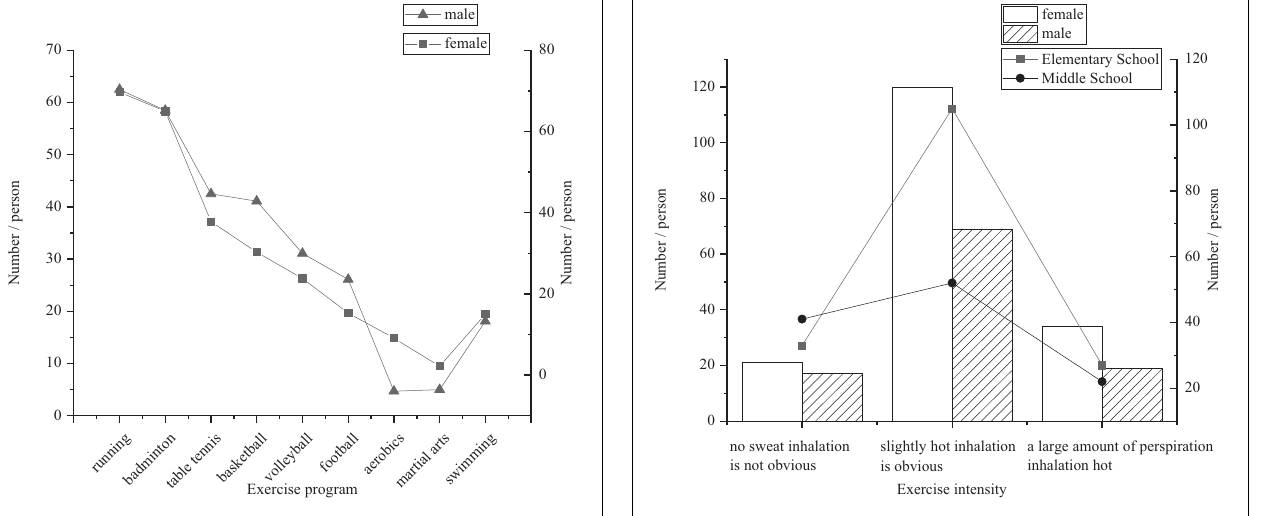
FIGURE 4 | Physical exercise programs of primary and middle school students in Tianjin.